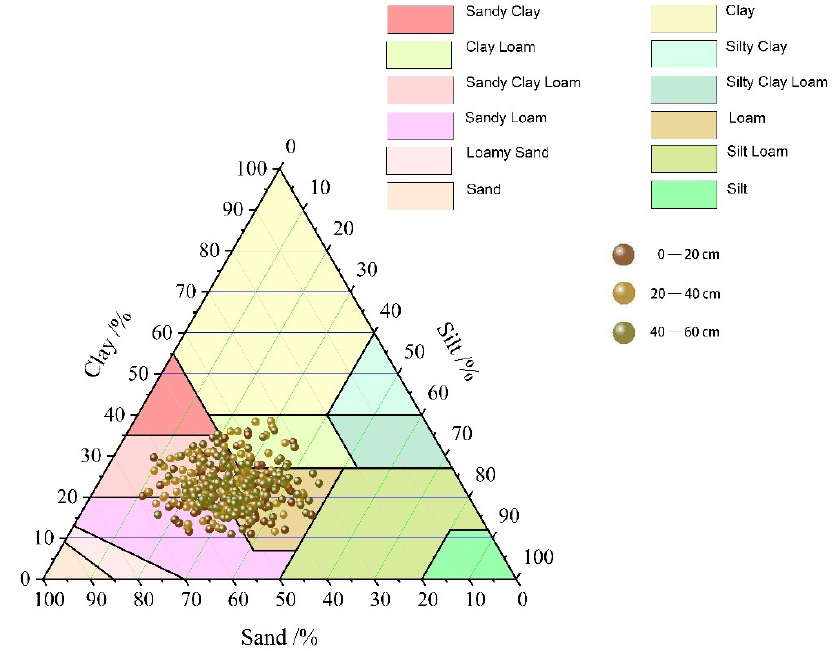
Figure 1. Soil texture types at all plots in study area.